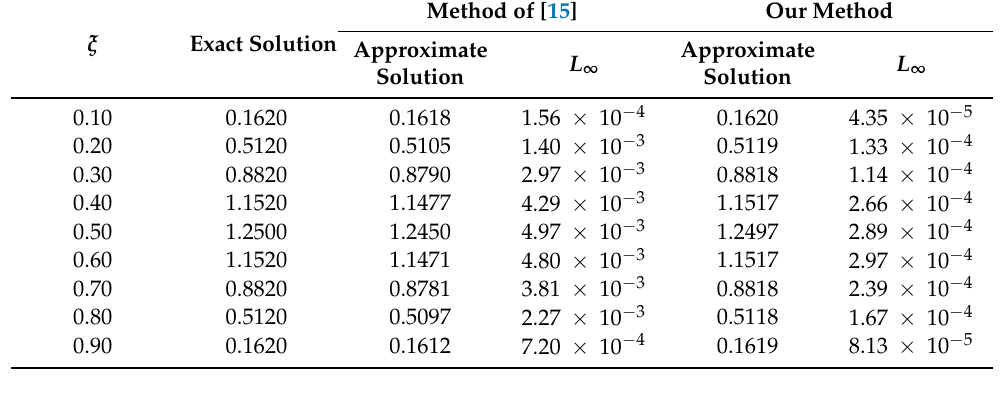
Table 3. The comparison of approximate solutions and L ∞ errors of our method with n = 5, M = 28,10 + 12 < κ < 10 + 16 at t = 1, and the method in [15] corresponding to Problem 2.